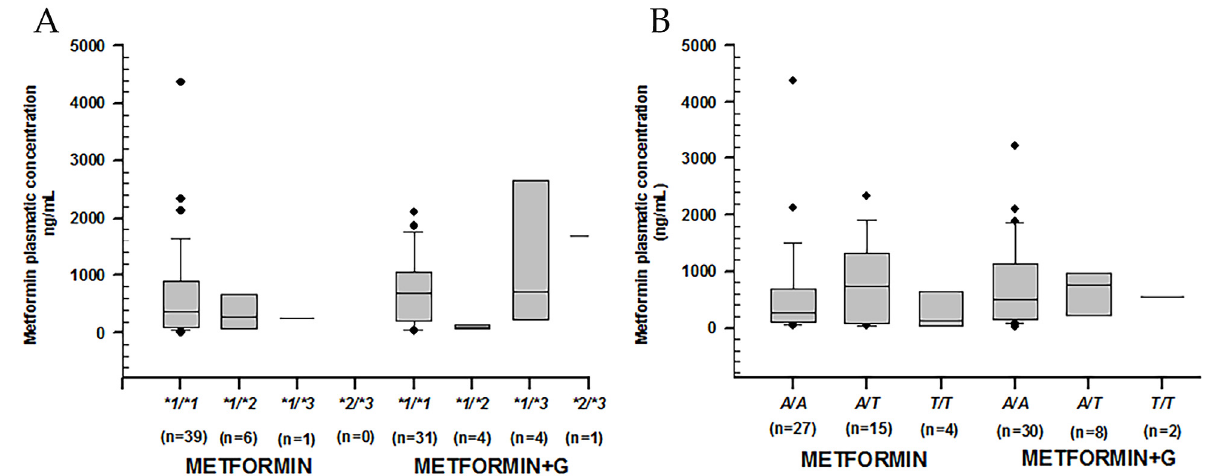
Figure 3. Metformin plasmatic concentration boxplots (ng/mL), including medians, interquartile ranges, and outliers (filled circles). ( A ) rs1799853 (*1/*2 ) and rs1057910 (*1/*3 ) in CYP2C9 . ( B ) rs1934969 (IVS8 109 A/T ) in CYP2C9 . Metformin to the left, metformin + glibenclamide to the right according to genotype. No statistical difference was found either intra-group or extra-group.